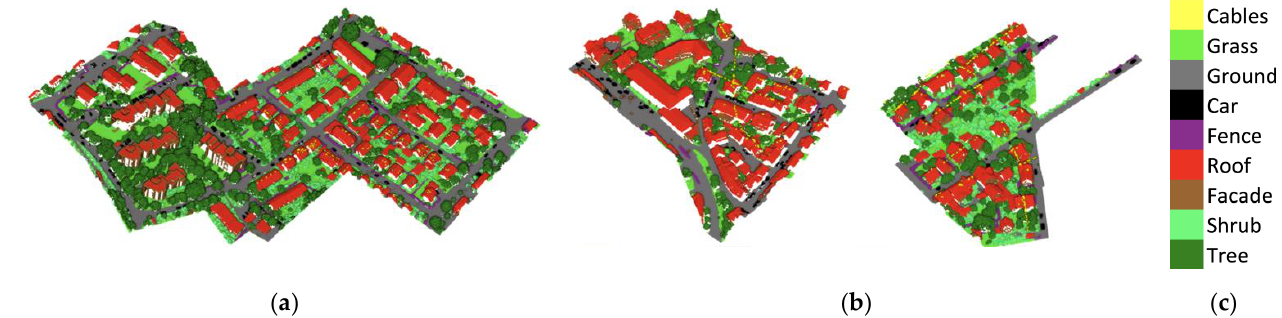
Figure 8. ISPRS Vaihingen point cloud with its nine classes. ( a ) Training, ( b ) test sections and ( c ) legend.